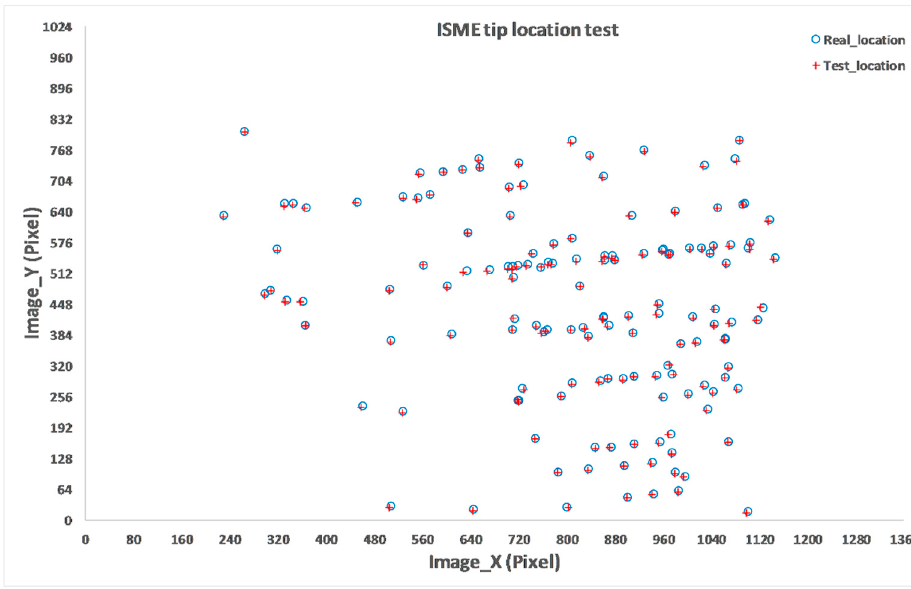
Figure 16. The ISME tip location test result of 145 images.